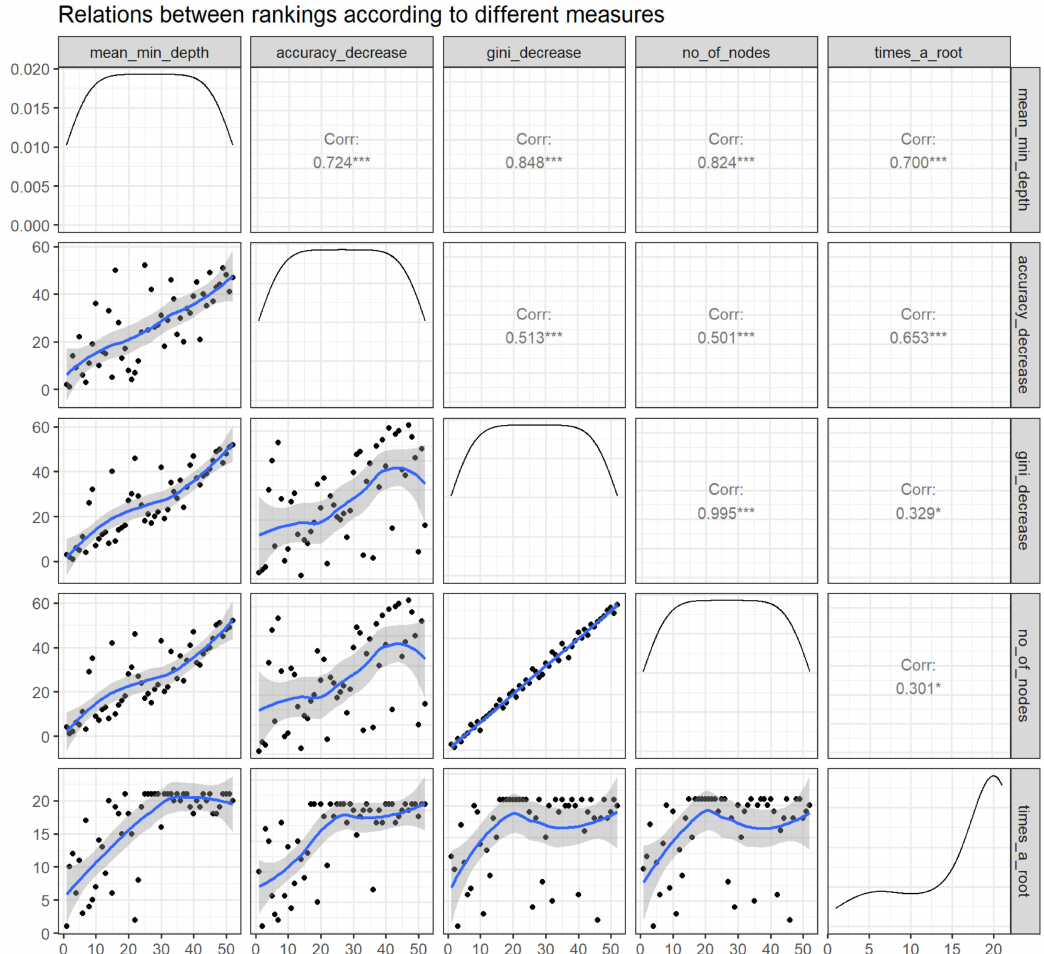
Figure 5. Relations between rankings according to different measures (panels in the lower triangle of the grid displaying distribution of rankings of all predictor variables with black dots accompanying a blue trend line) as well as correlation coefficient over rankings of any 2 parameters (panels in the upper triangle of the grid). Abbreviations: No—Number; min—Minimum; Corr—correlation. * p < 0.05, *** p <